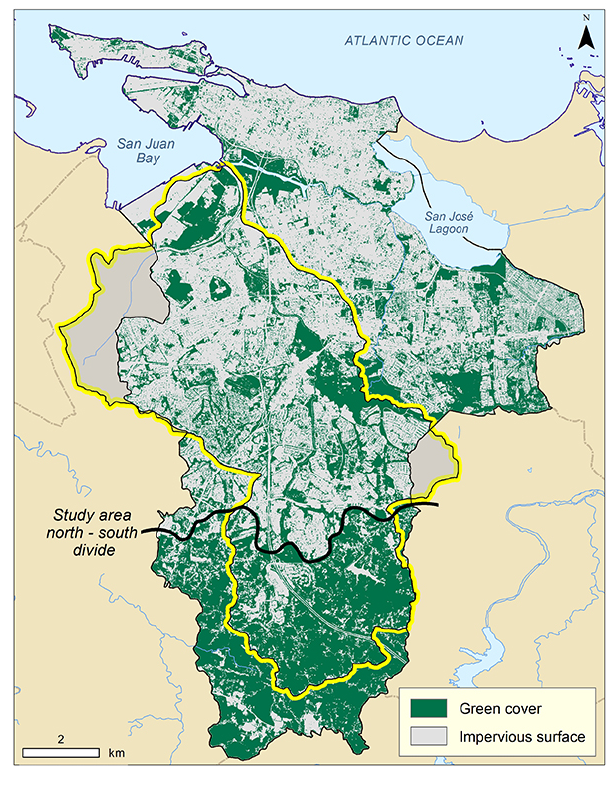
Fig. 1. Map of the green areas of the municipality of San Juan, Puerto Rico. The Río Piedras River watershed is highlighted in